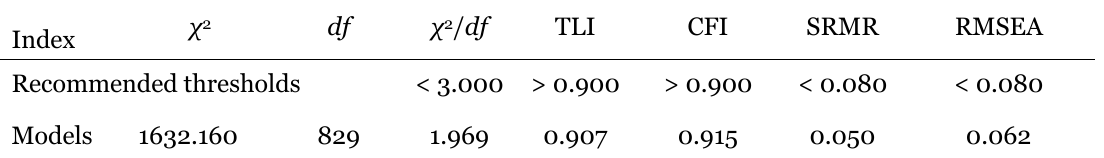
Results of Confirmatory Factor